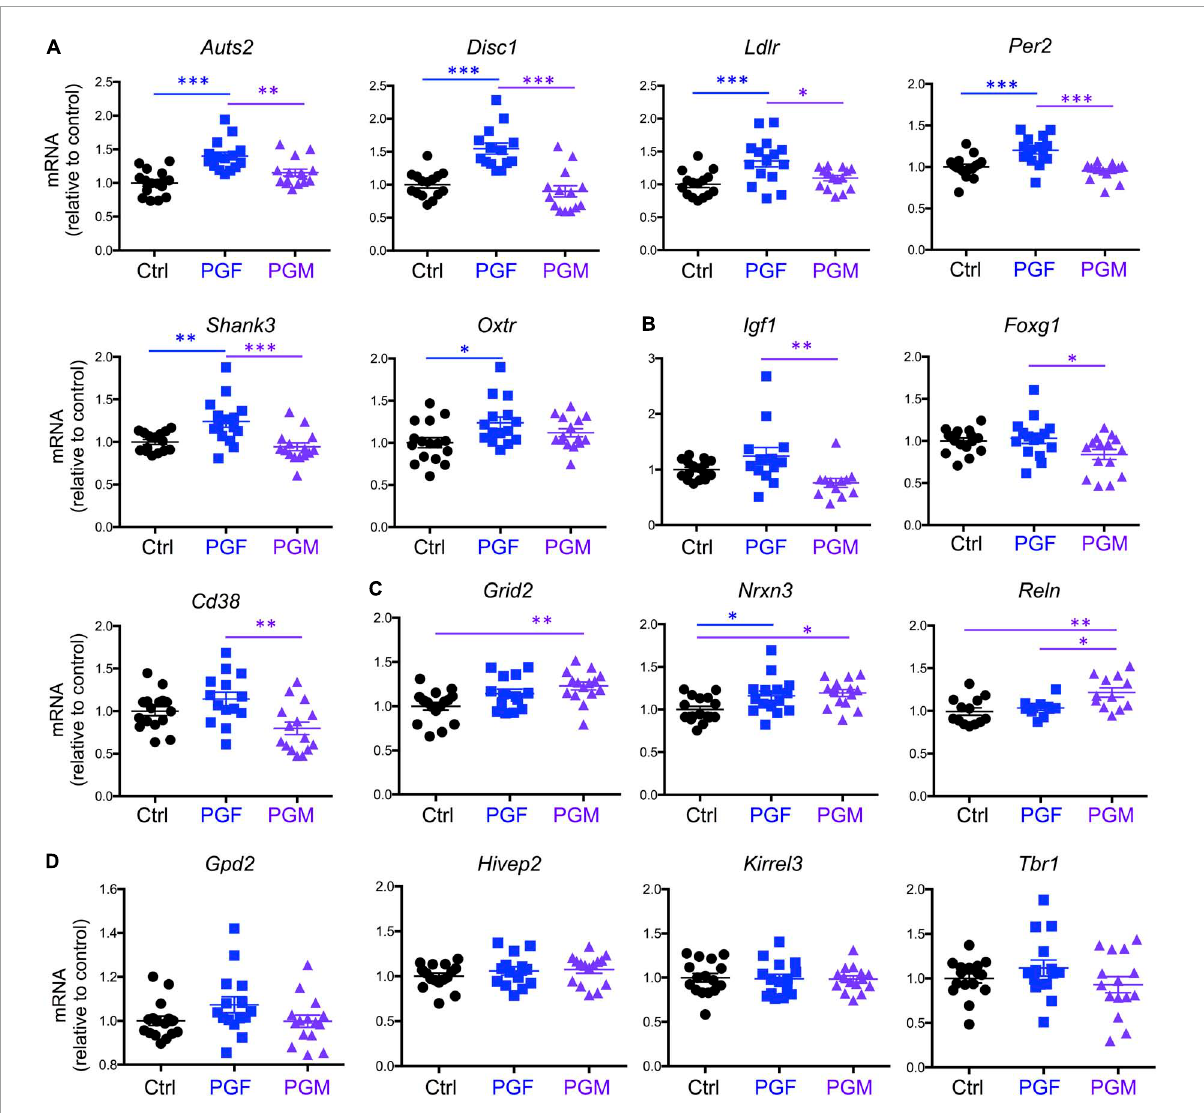
FIGURE2 Expression of neurodevelopmental disorders genes in E13.5 PGF and PGM brains. (A) Genes showing increased expression in PGF fetal brains. (B) Genes showing a decreased in PGM brains. (C) Genes showing an increase in PGM or in both PGF and PGM. (D) Genes showing no different expression between experimental groups. Each point represents a different embryo ( n = 16, 15, 15) and mean ± SEM are shown. Experimental embryos represent 3–4 different litters. ∗ , ∗∗ , and ∗∗∗ indicate P < 0.05, 0.01, and 0.001, respectively, as determined by ANOVA and Tukey’s post-hoc